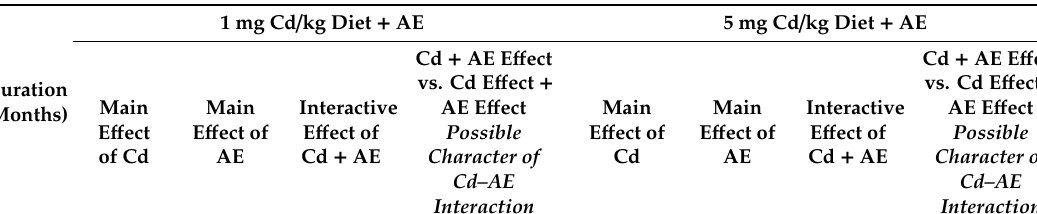
Table 3. Evaluation of the main and interactive e ff ects of cadmium (Cd) and Aronia melanocarpa L. berry extract (AE) on the ratio of the expression of collagen type III to that of collagen type I at the mRNA and protein levels in the livers of rats 1,2